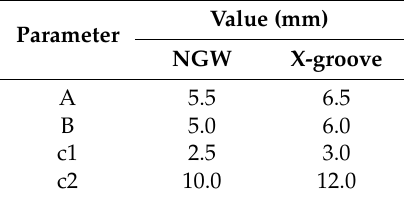
Table 6. Parameters of the heat source.